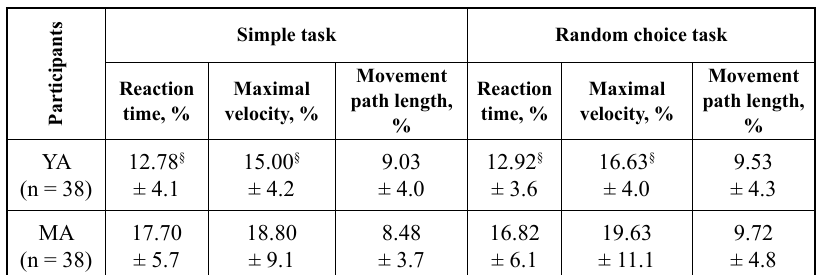
Table 1. Average values of motor task performance between the groups of middle-aged and young adults Note. MA – middle-aged adults; YA – young adults; * – difference statistically significant at 0.05 level as compared with values between different tasks;